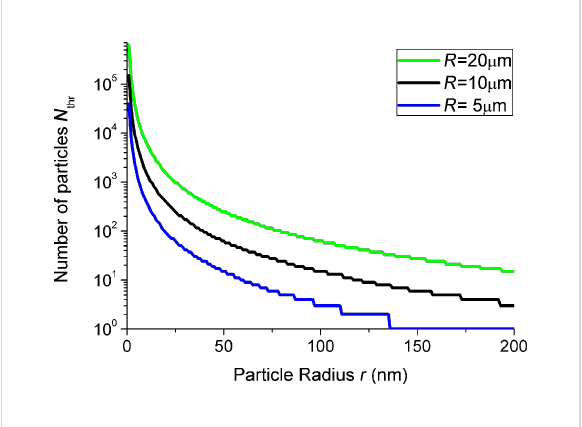
Figure 8: Determination of the threshold number of particles N thr for an uptake without volume loss. The different curves represent different initial vesicle radii R . g ad = − 0.5 mJ/m 2 and g ten = 200 mN/m were chosen as